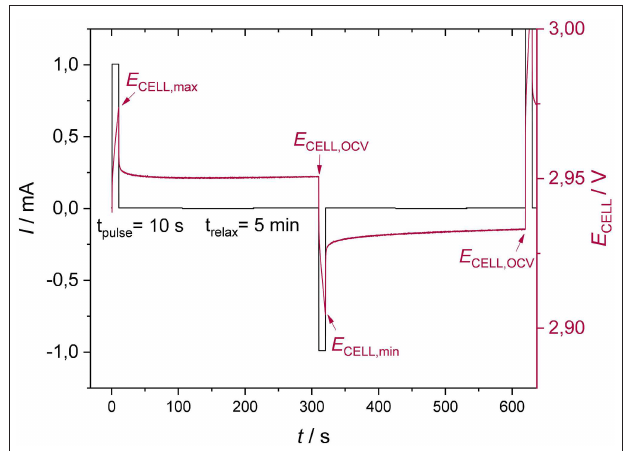
FIGURE 2 | Measurement procedure for estimating current and overpotential relation of lithium-ion batteries.